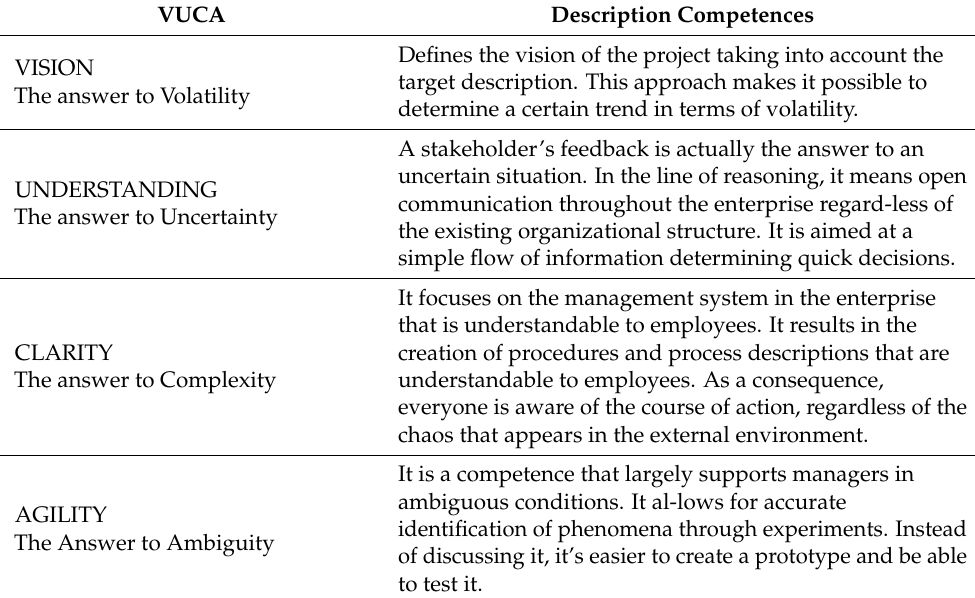
Table 1. Assignment of managerial competences to